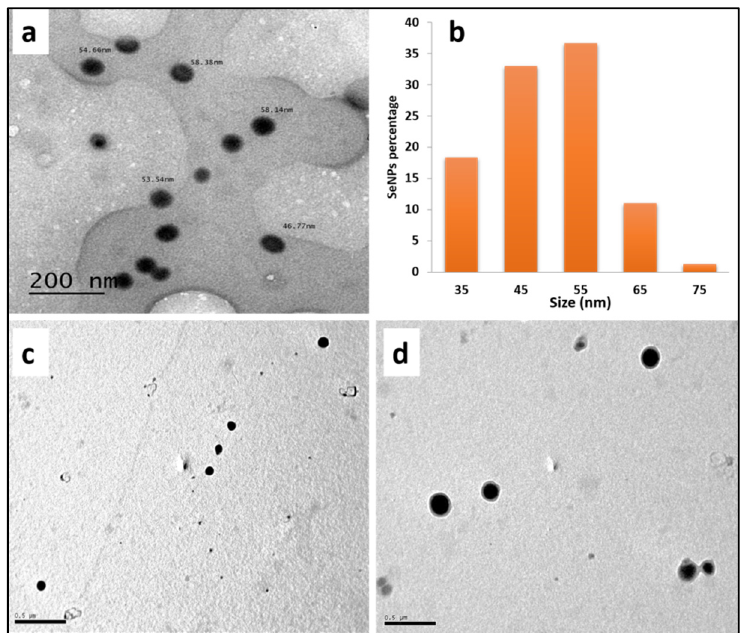
Figure 1. ( a ) TEM image ( b ) size distributions histogram of prepared SeNPs, ( c , d ) SeNPs-PP fabric surface.